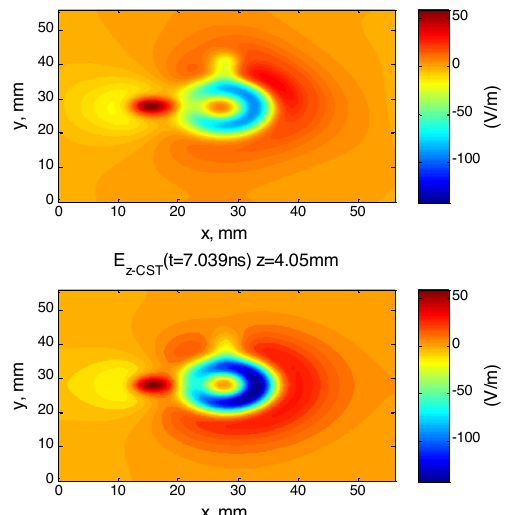
Figure 17: Comparison of E CST simulation and the proposed computation